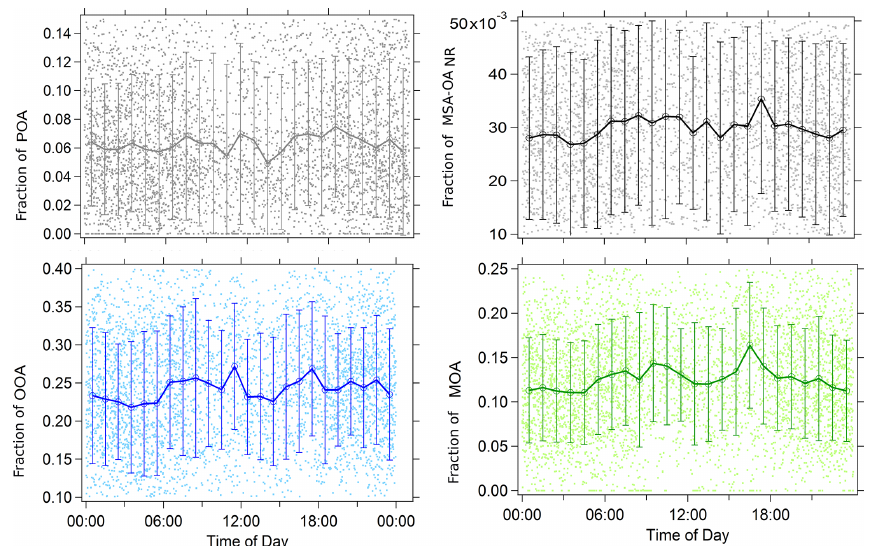
Figure 5. Diurnal variation in the four PMF organic factors chosen to represent the measured non-refractory organic aerosol: average (circles) and standard deviation (vertical bars) of the measurements by hour during the whole PEACETIME cruise. The underlying raw data are shown with small